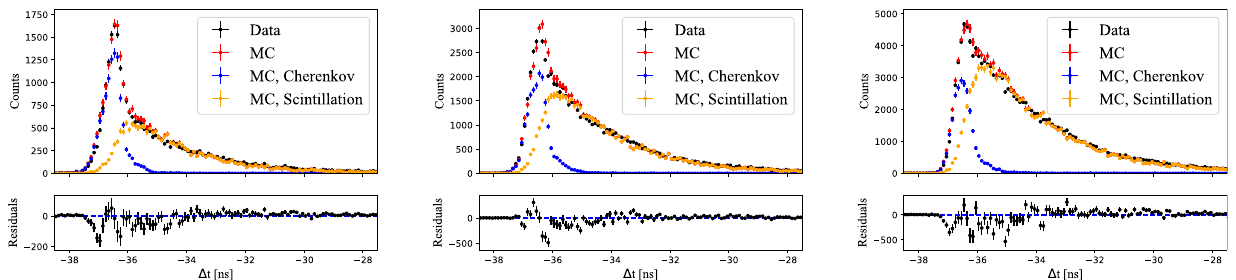
tracted out of the data. The MC model shows improved agreement with the data, relative to the analytic fits, in the Cherenkov peak